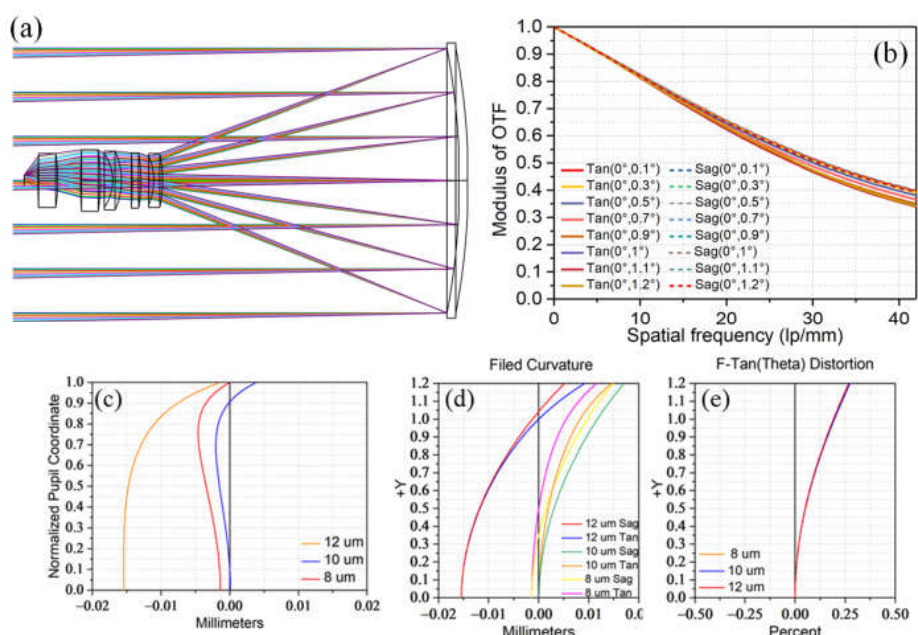
Figure 10. Fore-catadioptric path. ( a ) Optical layout diagram. ( b ) Modulation transfer function diagram. ( c ) The longitudinal chromatic aberration diagram. ( d ) Field curvature of the different wavelengths. ( e ) Distortion of the different wavelengths.